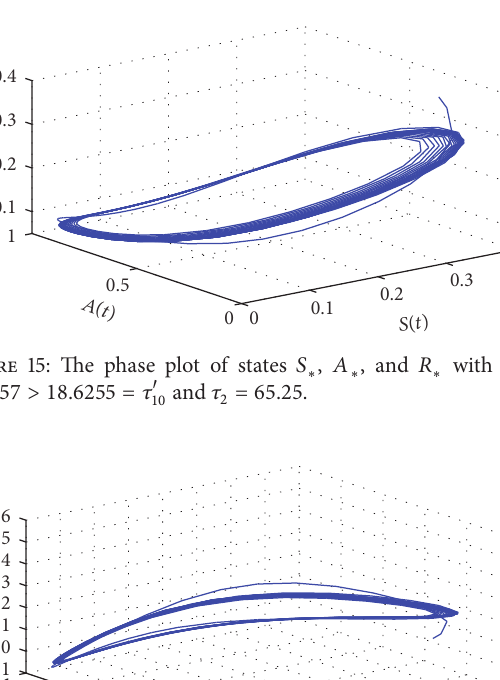
𝜏 = 65.25 2 10 and